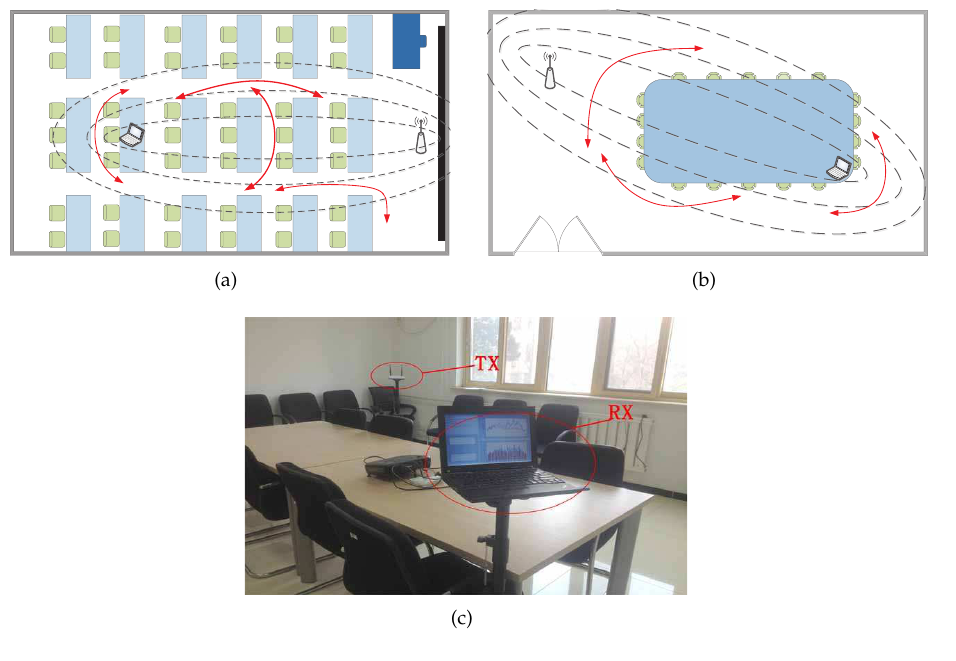
Figure 11. Experimental Scenarios: ( a ) Floor plan in classroom; ( b ) Floor plan in meeting room; ( c ) Experimental